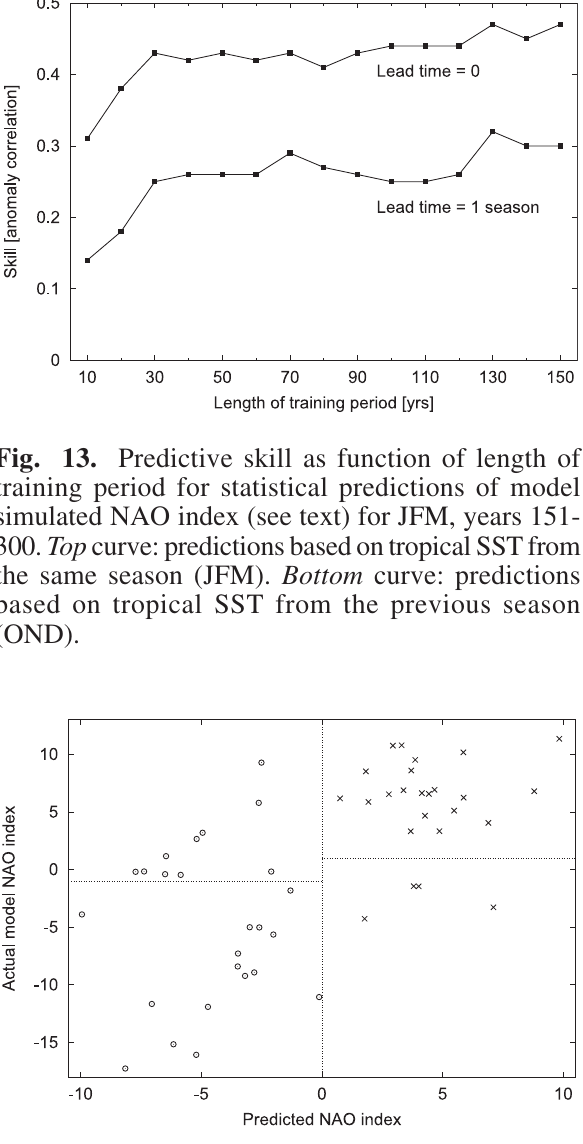
Fig. 14. Actual model NAO index versus statistically predicted NAO index for 25 warm ENSO years (circles) and 25 cold ENSO years (crosses). Lead time = 0, length of training period = 50 years. See text for further